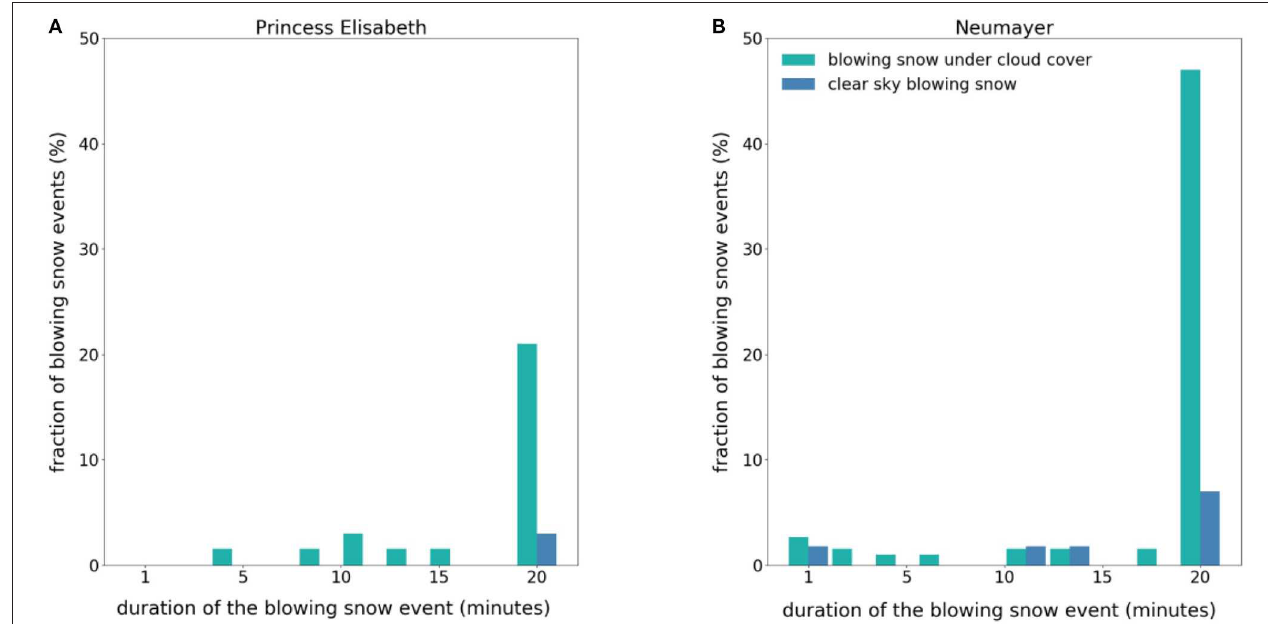
FIGURE 6 | Distribution of the blowing snow frequencies as detected by the ceilometer over the collocated timeseries. The length of the event is displayed along the x-axis (in minutes, 20 min being 100%) and the proportion of events as y-axis. The proportion represents the number of events over the total of these events (e.g., the fraction of blowing snow accompanied with clouds over the total number of cloudy events and the fraction of clear sky blowing snow over the total number of events during clear sky conditions) at (A) Princess Elisabeth and (B) Neumayer